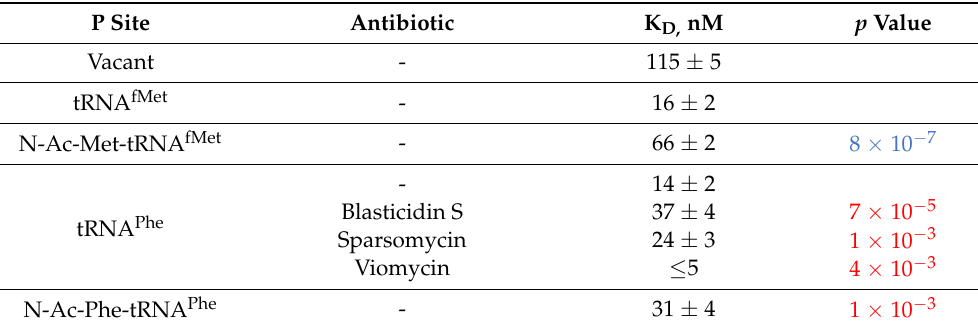
Figure 3. Deacylation of P-site tRNA moderately enhances EF-G binding. ( a ) EF-G fluorescence (I) normalized to fluorescence observed in the absence of the ribosome (I 0 ) was measured with increasing concentrations of ribosome complex P-site tRNA fMet (blue), N-Ac-Met-tRNA fMet (black), tRNA Phe (red) or N-Ac-Phe-tRNA Phe (orange). ( b ) Dissociation constants (K D ) of EF-G binding determined using fluorescein quenching by ribosomes that contain in the P site either deacyl- or N-Ac-aminoacyl-tRNAs. Table 1. Effects of P-site tRNA deacylation and antibiotics on dissociation constants (K D ) of EF-G